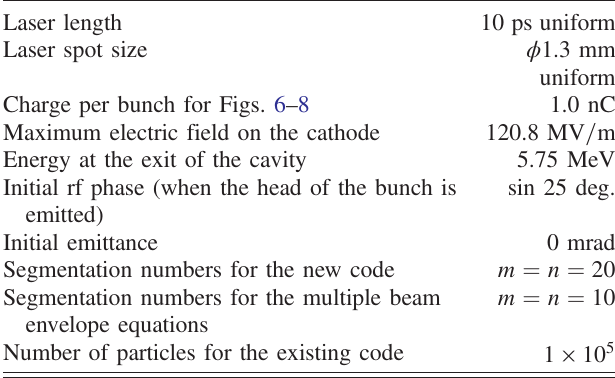
TABLE I. Parameters for calculations of beam dynamics in the BNL-type rf gun cavity.